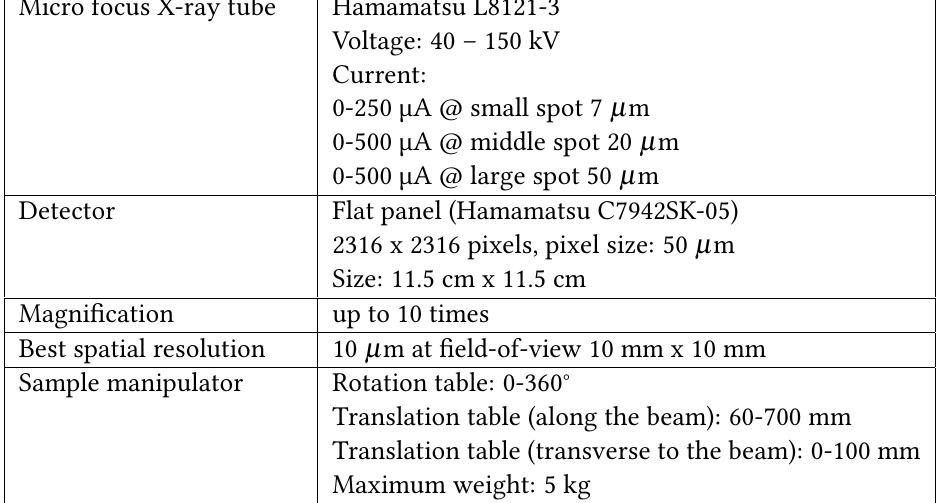
Rotation table: 0-360° Translation table (along the beam): 60-700 mm Translation table (transverse to the beam): 0-100